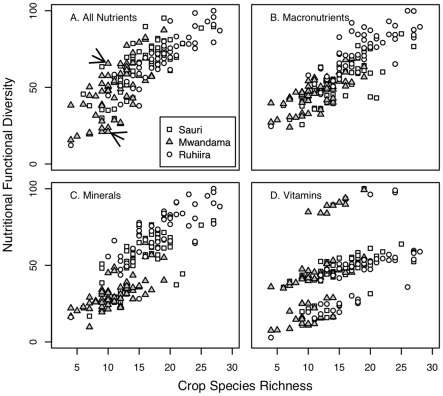
Nutritional functional diversity values are plotted against species richness for 170 household farms.A: Nutritional FD = FDtotal, summarizing functional diversity for all 17 nutrients listed in table 1; B: Nutritional FD = FDmacronutrients for the four macronutrients; C: Nutritional FD = FDminerals for the seven minerals; D: Nutritional FD = FDvitamins for the six vitamins (table 1). Farms in Mwandama are shown as triangles, farms in Sauri as squares, and farms in Ruhiira as circles.